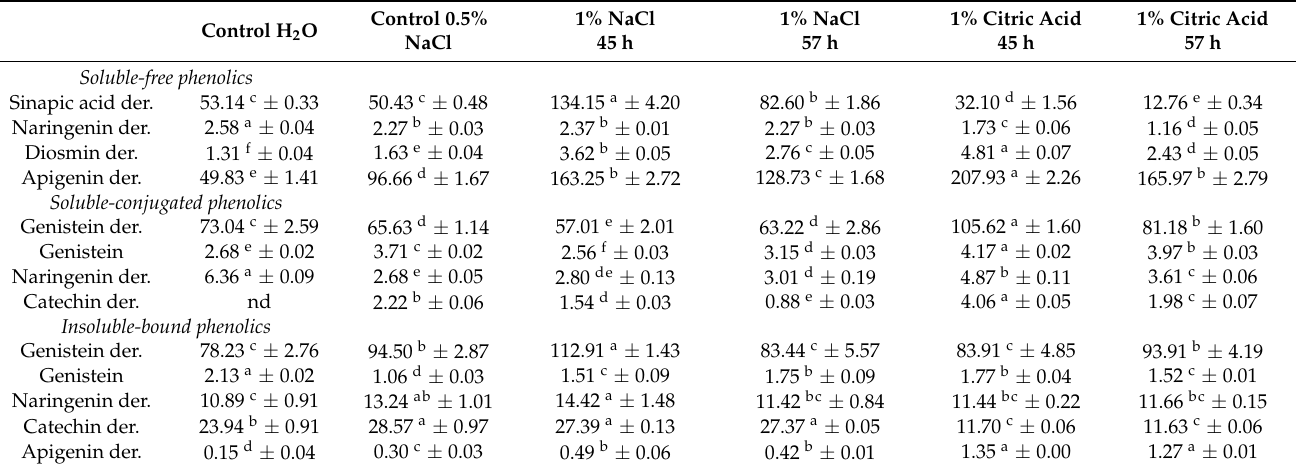
Table 4. Phenolic content (mg/kg DM; mean ± standard deviation) in Lupinus albus seeds (Lot 2) debittered by the control methods with water (Erba¸s [28], modified by C ó rdova-Ramos et al. [27]) or with 0.5% NaCl [31], and the experimental method with different solvents [25].